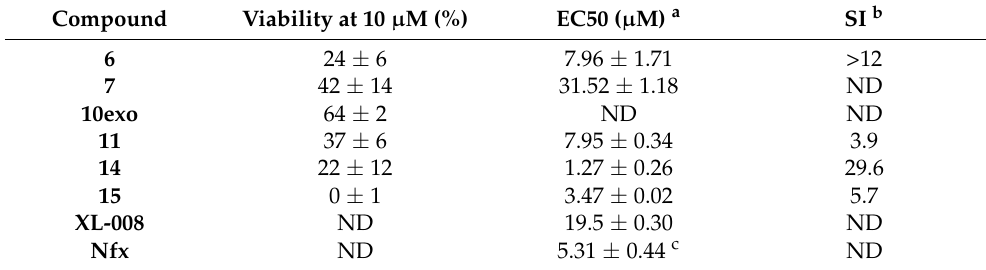
Table 1. In vitro activity of iboga-like compounds against bloodstream T. b. brucei .